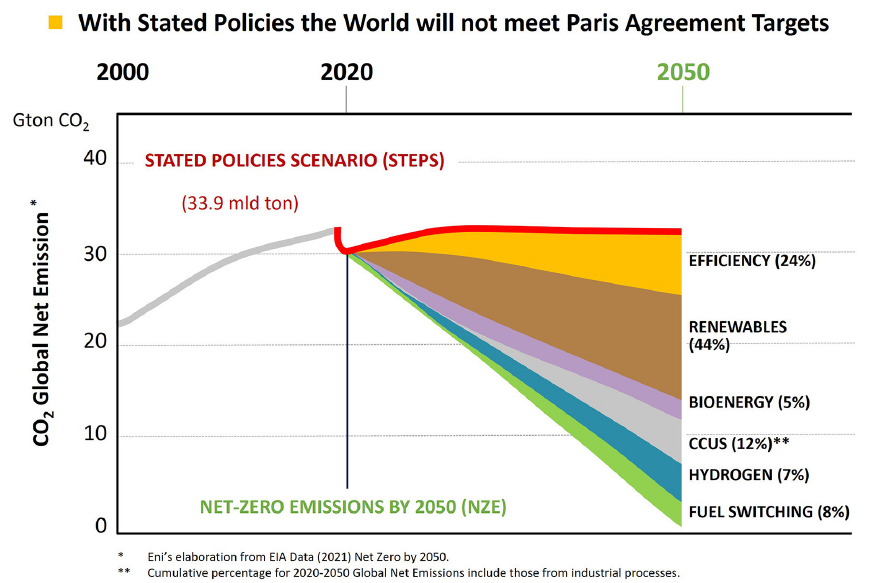
Fig. 5. – Greenhouse Gas Emissions —The Climate Change Challenge (Source: Eni/EIA, 2021). the Paris Agreement targets. Reaching net zero by 2050 will require further massive reductions through increased efficiency, the use of renewables, bioenergy, CCS, hydrogen and fuel switching (fig. 5).